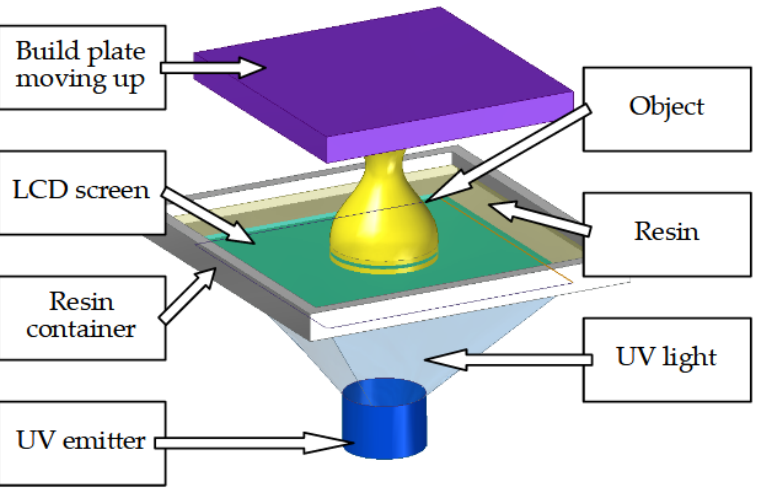
Figure 8. Main components of an SLA printer.